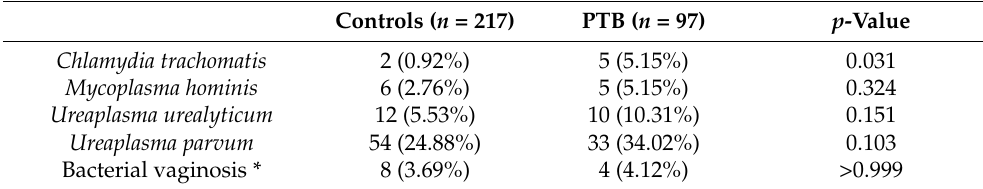
Table 3. Number of positive cases and prevalence of C. trachomatis , M. hominis , U. urealyticum , U. parvum, and bacterial vaginosis in women with uneventful pregnancy (control group, n = 217) and in women who spontaneously delivered before 37 weeks of gestation (PTB group, n =